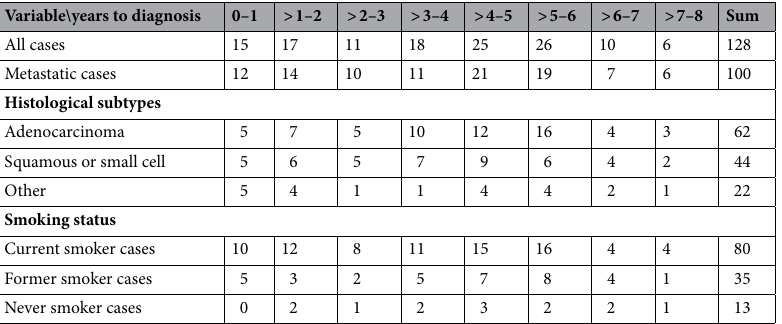
Table 2. Number of cases according to years to diagnosis for all cases, metastatic cases, histological subtypes and smoking status.